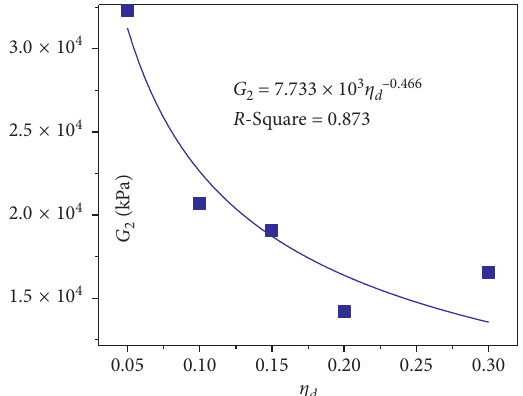
Figure 15: Relationship between G